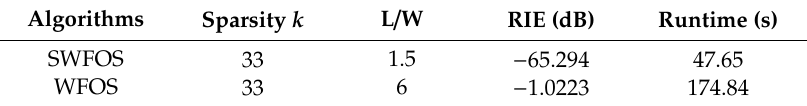
Figure 7. Imaging results for the sparse target in the PL-TCAI system with the setting SNR = 20 dB: ( a ) SWFOS algorithm with L / W = 1.5; and ( b ) WFOS algorithm with L / W = 6. Table 2. Performance comparison of algorithms in PL-TCAI